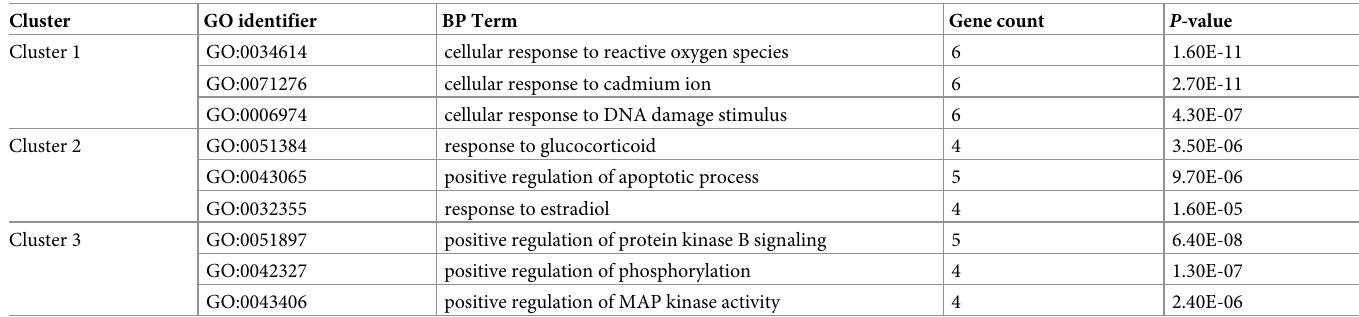
Table 4. Description of Top 3 biological processes of target clusters within 31 key targets of EH-CS compounds for obesity as determined using STRING database. Cluster GO